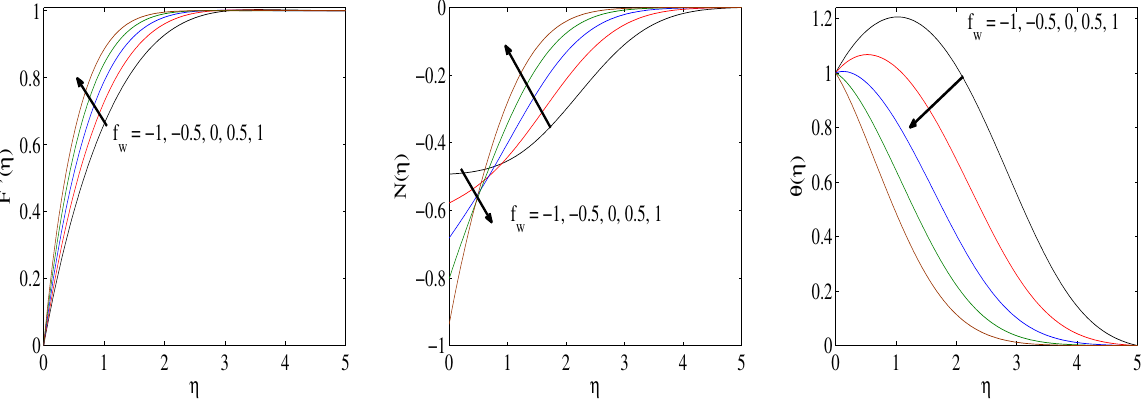
Figure 3. Velocity and angular velocity distribution under the impact of f w